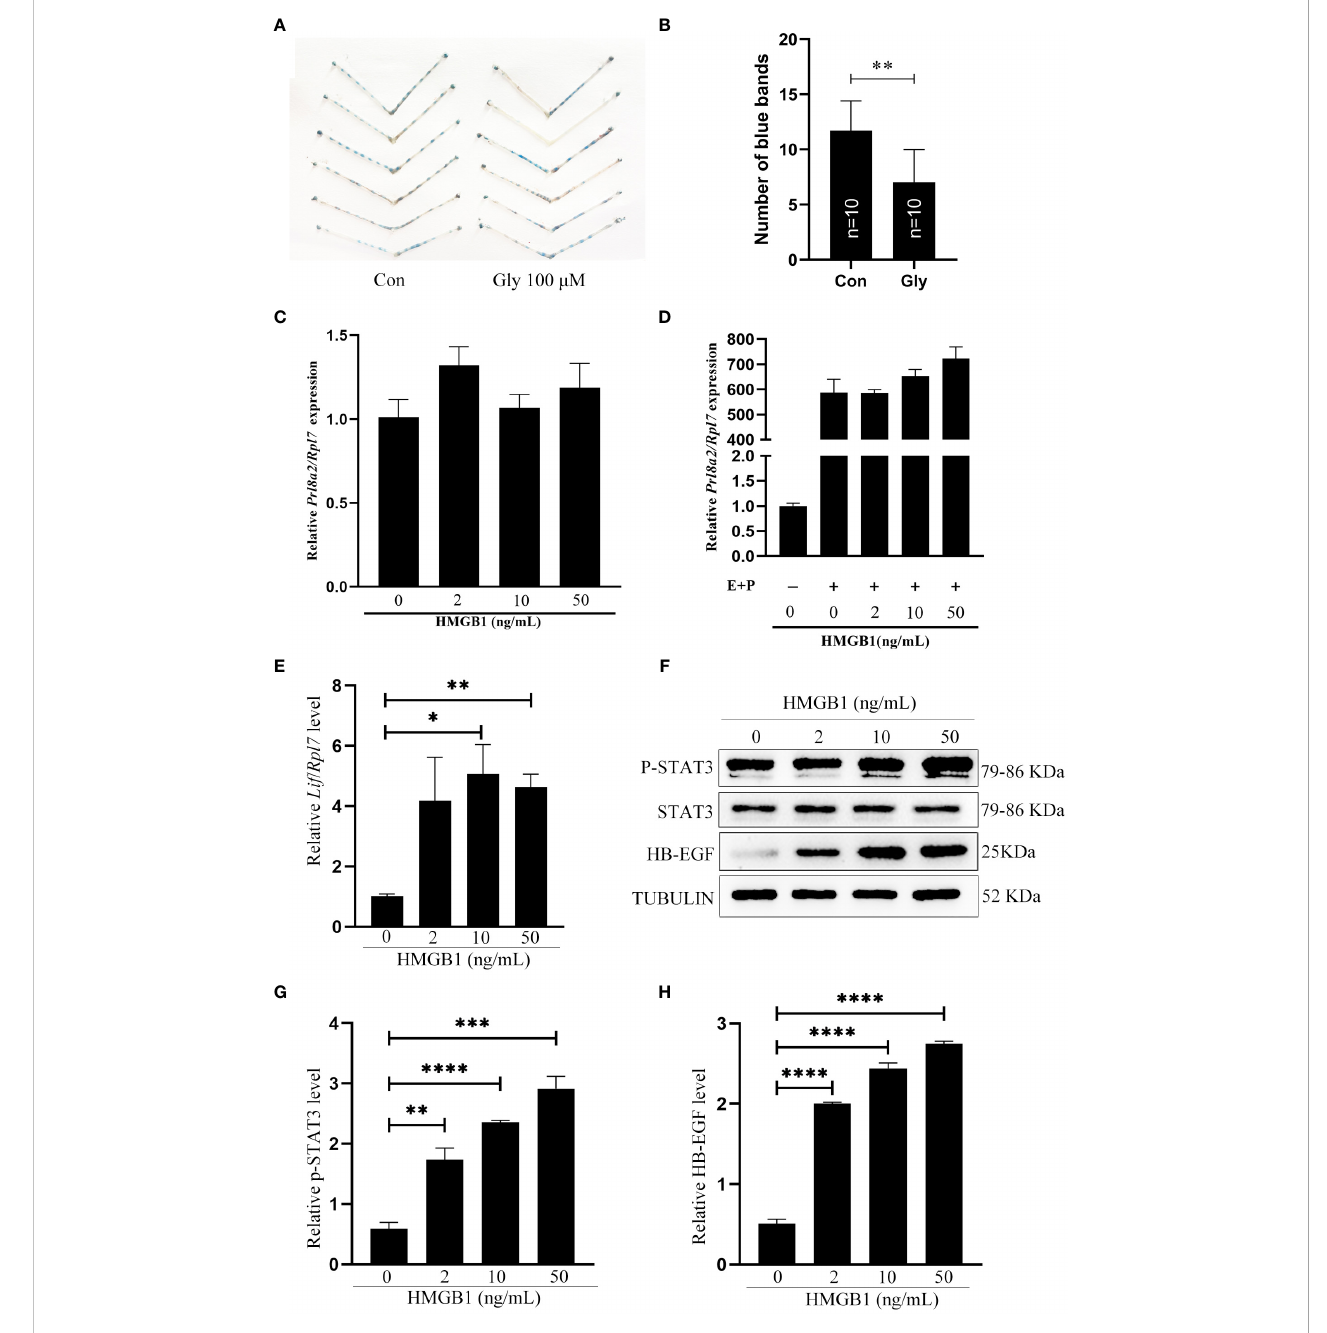
FIGURE 3 Effects of recombinant HMGB1 proteins on mouse implantation and decidualization. (A) The morphology of mouse uteri on day 5 of pregnancy after day 4 pregnant mice were intraluminally injected with 3 m l of saline or 100 m M Glycyrrhizin in saline at 09:00. (B) The number of implantation sites (blue bands) on day 5 of pregnancy after day 4 pregnant mice were intraluminally injected with 3 m l of saline or 100 m M Glycyrrhizin in saline at 09:00. The implantation sites were showed by injecting 0.1 ml of 1% Chicago sky blue through tail vein. (C) The Prl8a2 mRNA level after mouse stromal cells were treated with 0, 2, 10 and 50 ng/ml HMGB1 for 24 h, respectively. (D) The Prl8a2 level after mouse stromal cells were treated with 0, 2, 10 and 50 ng/ml HMGB1 for 24 h under in vitro decidualization, respectively. (E) The Lif mRNA level after mouse epithelial cells were treated with 0, 2, 10 and 50 ng/ml HMGB1 for 15 min. (F) Western blot analysis on the protein levels of p-Stat3, STAT3, and HB-EGF after mouse epithelial cells were treated with HMGB1 for 15 min. (G, H) The relative quanti fi cation of p-STAT3 and HB-EGF protein levels in Figure 3F. *p < 0.05, **p < 0.01, ***p < 0.001, ****p <